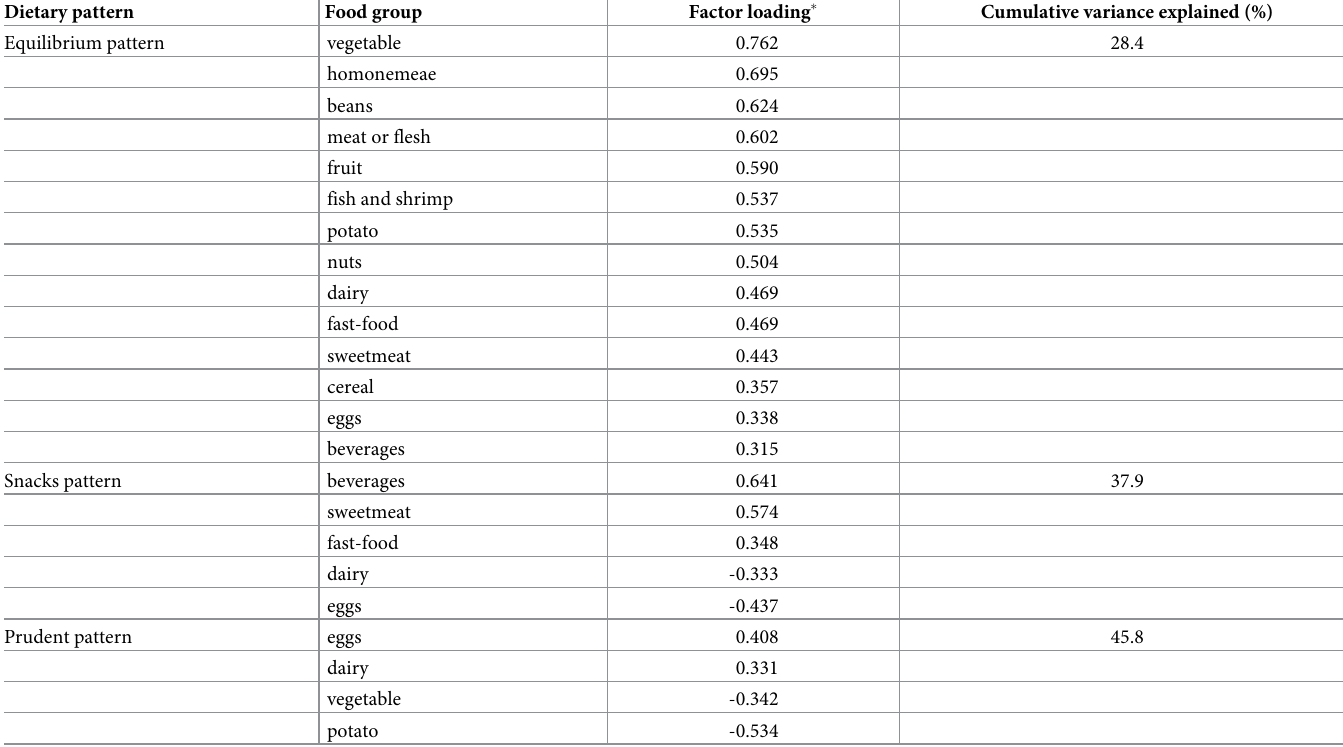
Table 1. Factor loadings for the identified dietary patterns among pregnant women (n 7934) in Shaanxi province, Northwest China,